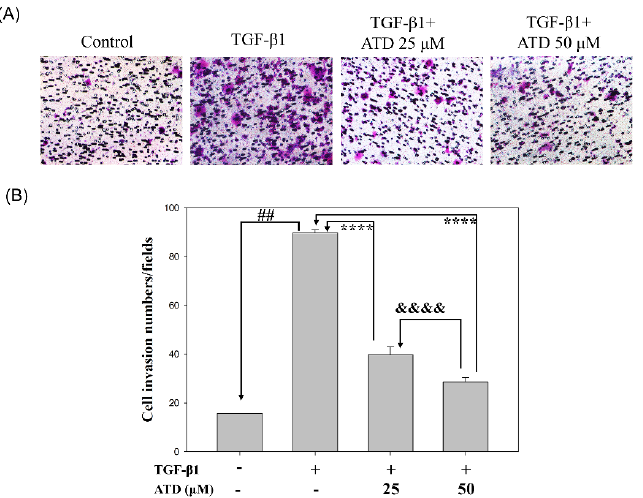
Figure 4. Effect of ATD on invasion induced by TGF- β 1 in HepG2 hepatoblastoma cells. Cells were pretreated with or without (control group) TGF- β 1 for 24 h, then co-treated indicated concentration of ATD and TGF- β 1 for an additional 24 h. Cells were harvested and seeded onto upper chamber which was coated with Matrigel. The transwell chamber assay was performed as described in the text. ( A ) After incubation for 24 h, invasion cells in the lower surface of membrane were fixed, then stained with crystal violet solution and photographed at 200 × magnification. ( B ) The invasion cells were quantified in 6 randomly selected fields per well (n = 6) using a light microscope. Data are represented as the mean ± SD. ##: TGF- β 1 vs. control, p < 0.01; ****: TGF- β 1 vs. TGF- β 1+ 25 μ M ATD or + 50 μ M ATD, p < 0.0001; &&&&: TGF- β 1+ 25 μ M ATD vs. TGF- β 1+ 50 μ M ATD, p < 0.0001.